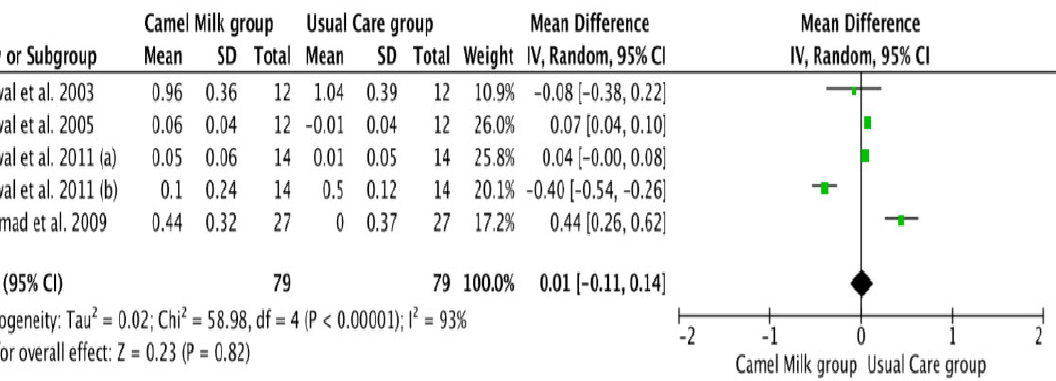
studies (difference between the two articles that are published by same author (Agrawal), same